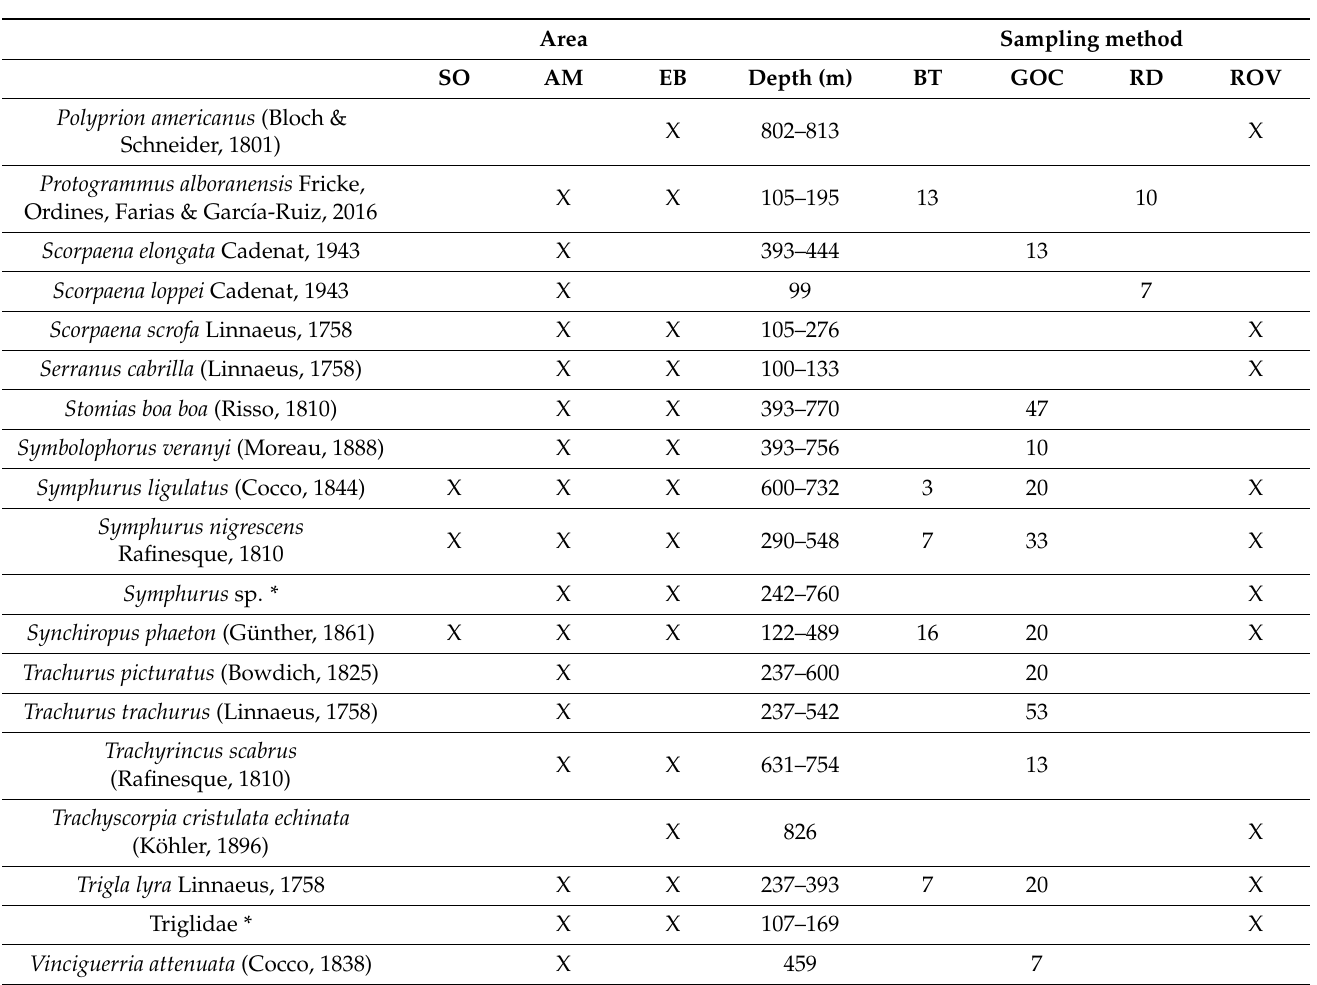
Table A7. Cont. Area Sampling method